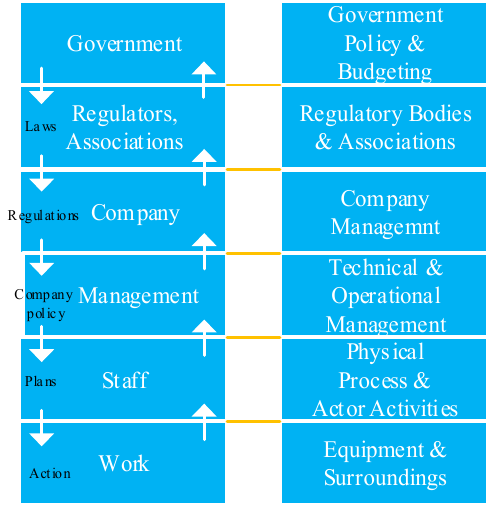
Figure 2. The risk management framework and Accimap approach by Rasmussen [10,11].